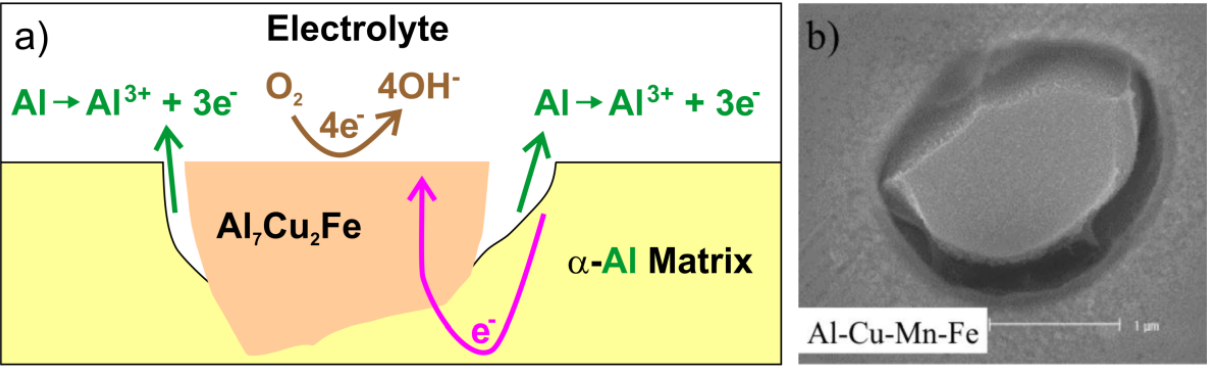
Figure 9. Schematic of the de-alloying and subsequent trenching of Al 2 CuMg intermetallic in AA2024 aluminum alloy ( a ); microstructure image of corroded alloy surface after 1-h exposure in aerated H 2 O at 30 °C ( b ), redrawn ( a ) and reproduced ( b ) from ref. [76].